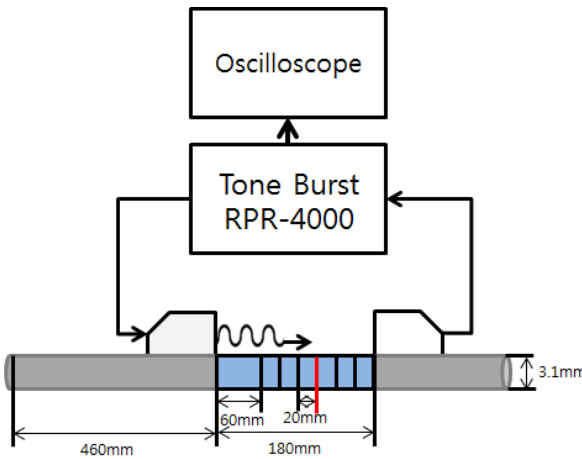
Figure 5. Diagram of second harmonic wave testing method.